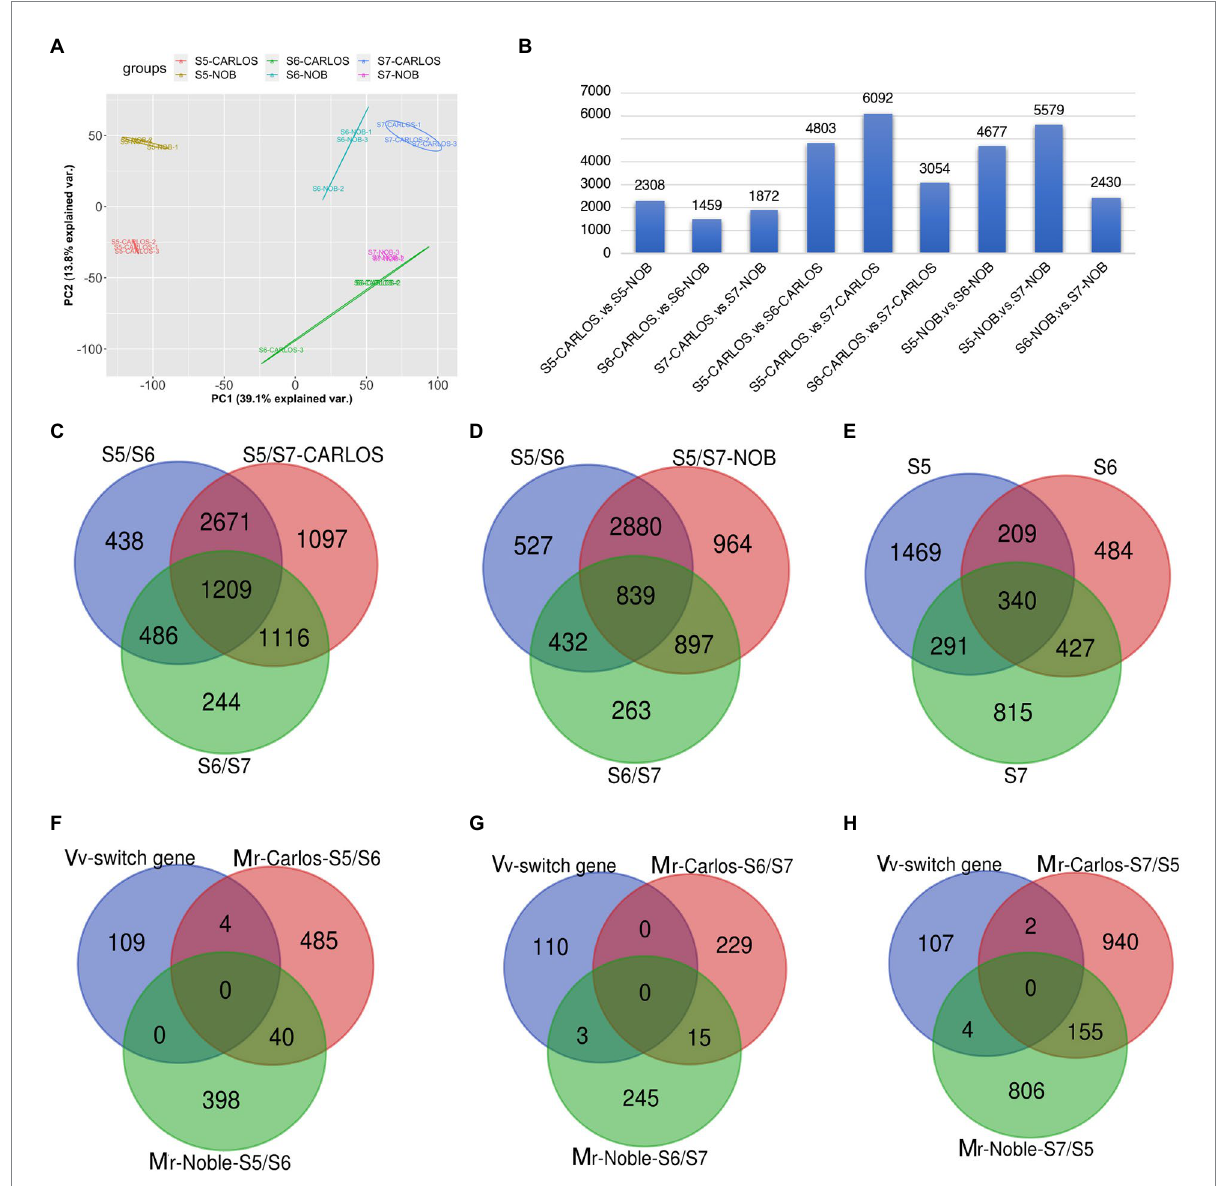
FIGURE 3 Gene expression patterns in the grape samples. (A) Principal component analysis (PCA) of transcriptome data from three stages of fruit ripening in two cultivars. Color code is shown. Each dot represents one sample. Color-coded lines and cycles show the replicates. (B) Total number of differentially expressed genes (DEGs) between cultivars and between two stages in one cultivar. Blue bar represents the number of DEGs. (C,D) Venn diagram illustrating the overlap of DEGs among E-L 32, E-L 35, and E-L 38 in “Carlos,” (C) ; and in “Noble,” (D) . (E) Total number of overlapping DEGs in both cultivars. (F,H) Stage-specific genes among the common switch genes in V. vinifera (Vv) and M. rotundifolia (Mr) “ Carols” and “Noble” in (E-L 32) (F) , (E-L 35) (G) , and (E-L 38) (H) . Bunch closure (S5/E-L 32), veraison (S6/E-L 35), and maturity (S7/E-L